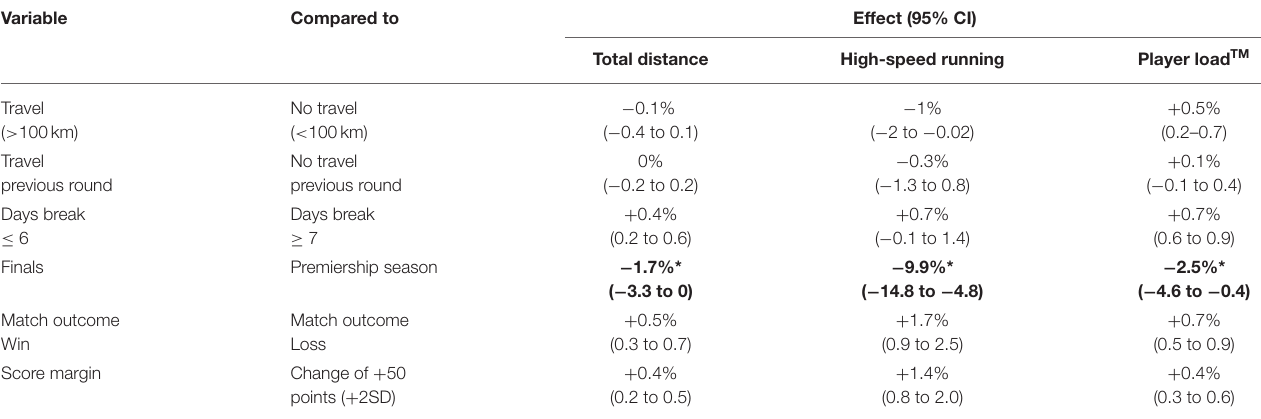
TABLE 5 | The effects of travel, days break, finals, match outcome, and score margin. Variable